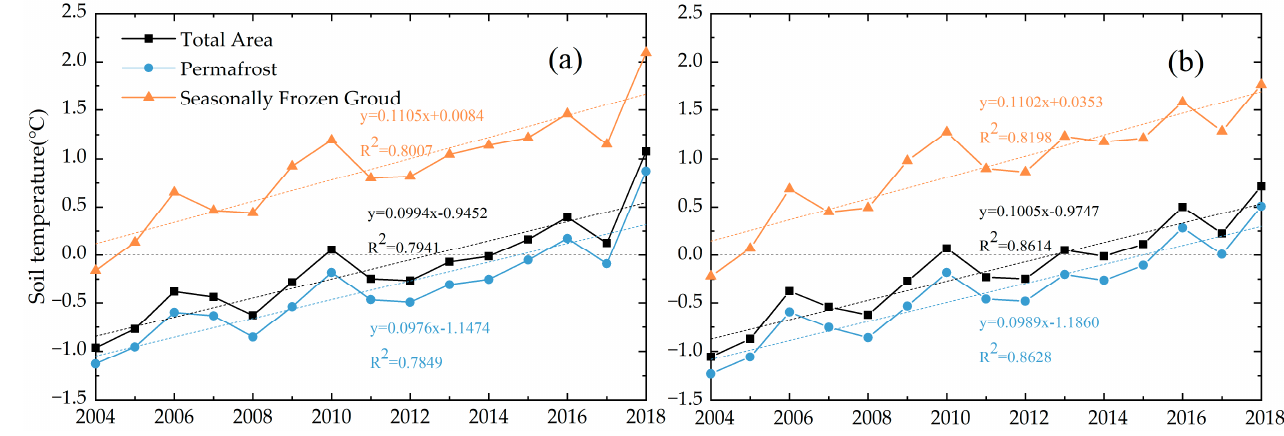
Figure 7. Annual variation in soil temperature of 10 cm ( a ), 50 cm ( b ).